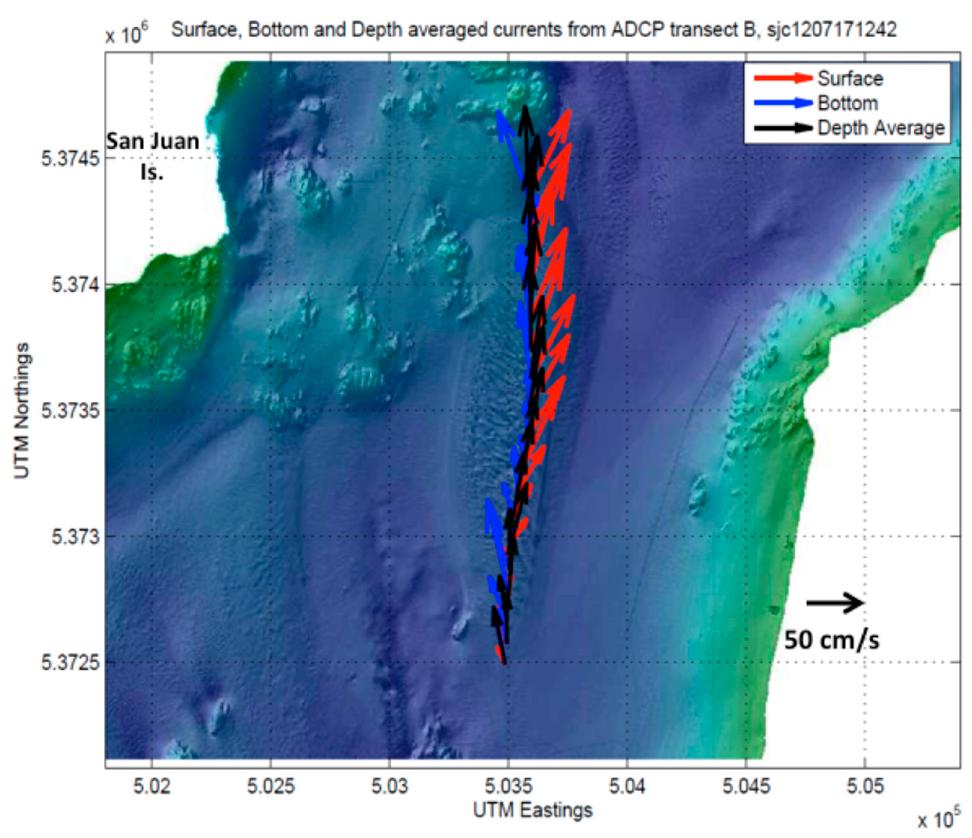
Figure 6. Surface, bottom, and depth-averaged currents observed during ADCP transect B aboard RV Centennial at flood tide, 17 July 2012.